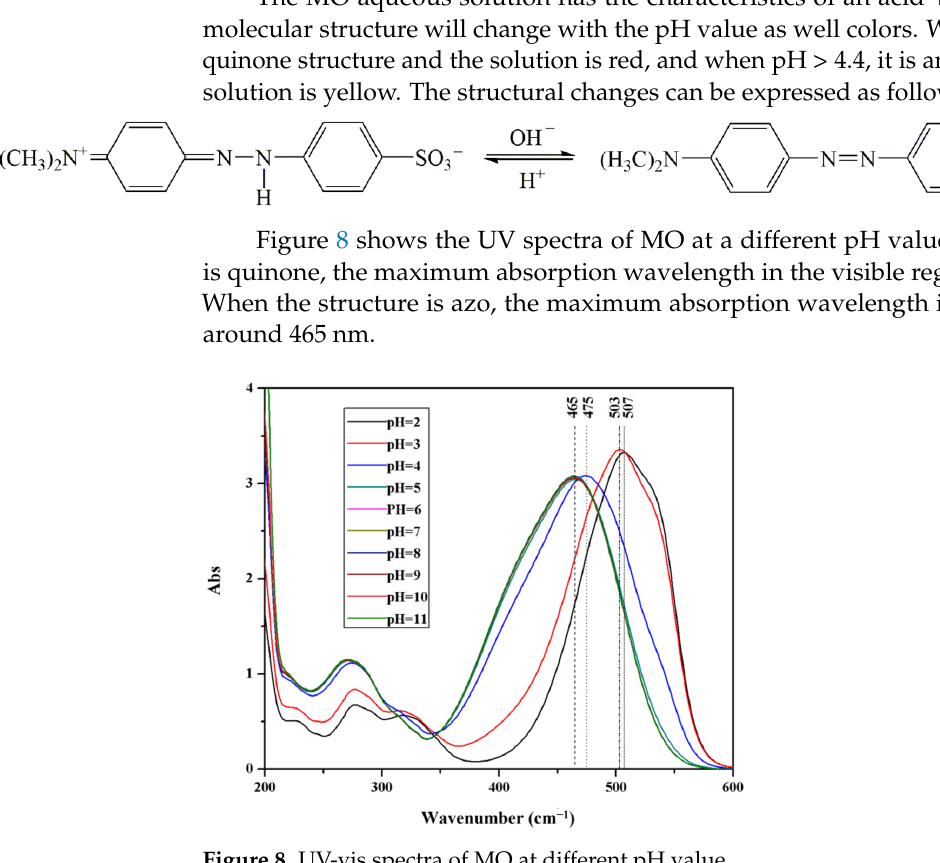
Figure 8. UV-vis spectra of MO at different pH